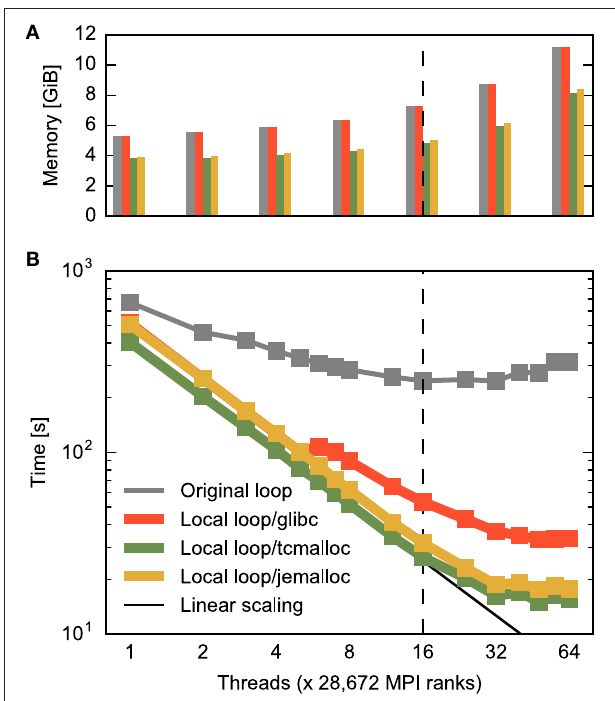
FIGURE 7 | Combined effect of improved memory allocation and loop order on construction time and memory consumption for a large neuronal network. (A) Memory consumption at the end of and (B) time required for construction of the large network. The horizontal axis specifies the number of threads per MPI process as in Figure 3B . Gray bars/curve indicate the original implementation (same data as total time in Figure 3B ), while red indicates results with loops carried out over local nodes ( Listing 3 , same data as total time in Figure 6 ). The green and yellow bars/curves combine this loop order with the memory allocators tcmalloc and jemalloc, respectively. The black curve in (B) indicates ideal scaling. The dashed vertical line indicates the number of physical cores available on a compute